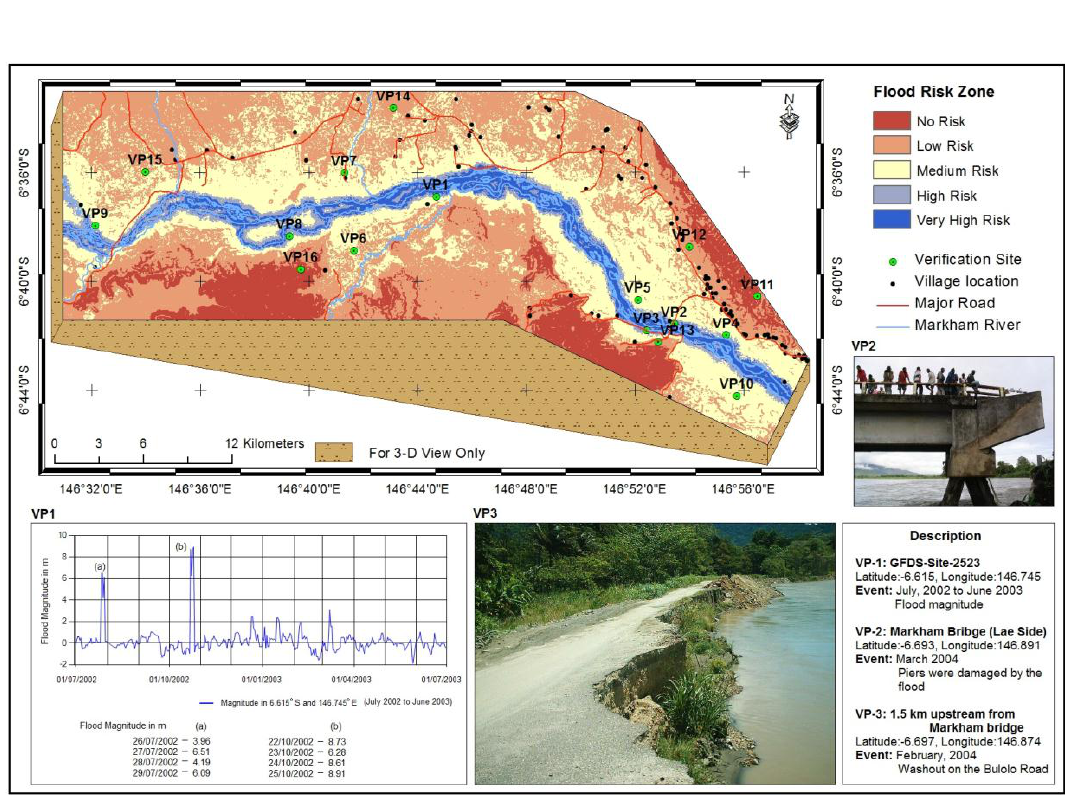
Figure 5. Validation of flood risk analysis at different sites with historical flood events and its